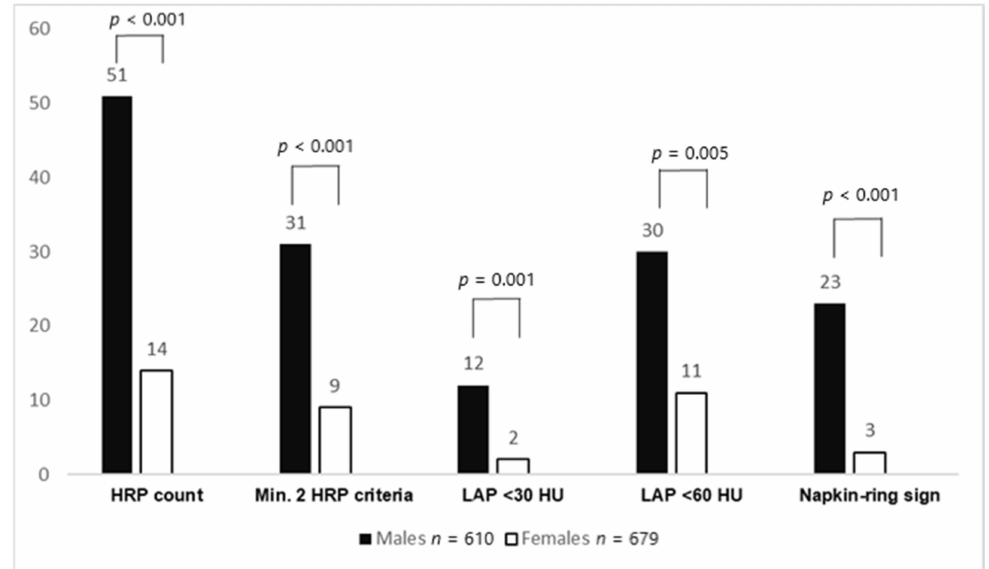
Figure 1. High-risk plaque (HRP) prevalence between males and females with a CACS of 0. Males had significantly more HRPs and HRP subcriteria than females. CACS: coronary artery calcium score; HRP: high-risk plaque, LAP: low-attenuation